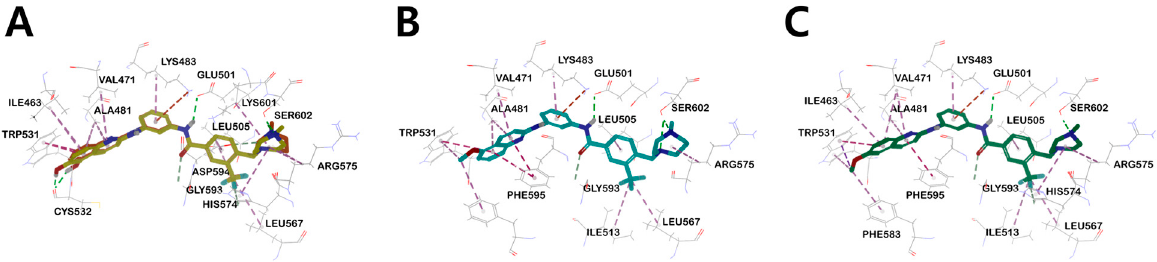
Figure 7. ( A ) Three-dimensional structural overlay of compounds 17b (orange) and 18a (yellow) inside B-RAF V600E protein. The binding mode of compound ( B ) 14b (sky blue), ( C ) 16a (green) in the B-RAF V600E protein. Inhibitors are shown in the stick model, and surrounding residues are shown in the line models. Various interactions are shown in dashes.